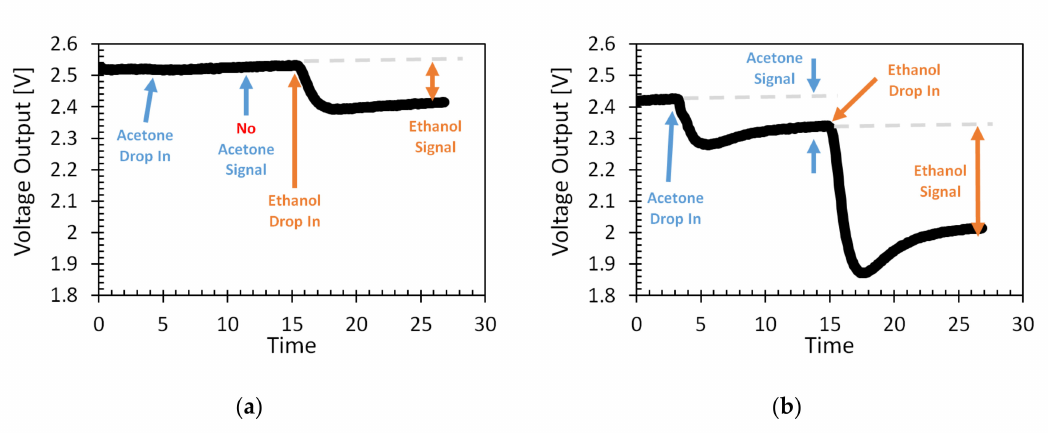
Figure 11. Voltage signal versus time at heater voltage of ( a ) 1.8 V and ( b ) 2.7 V, which correspond to low and high ignition temperatures, respectively. Concentration of each gas was about 100